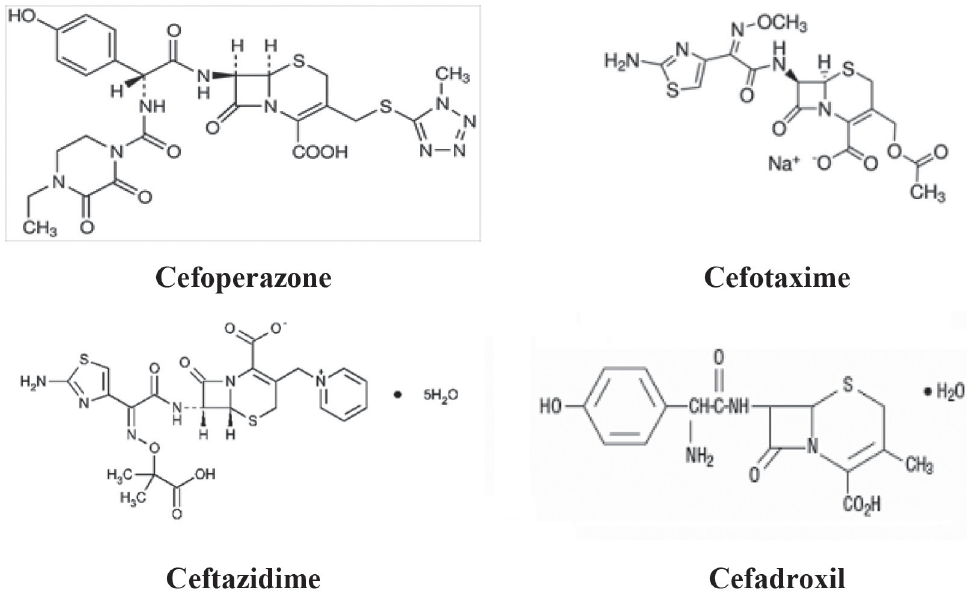
FIGURE 1 - Chemical Structure of the studied